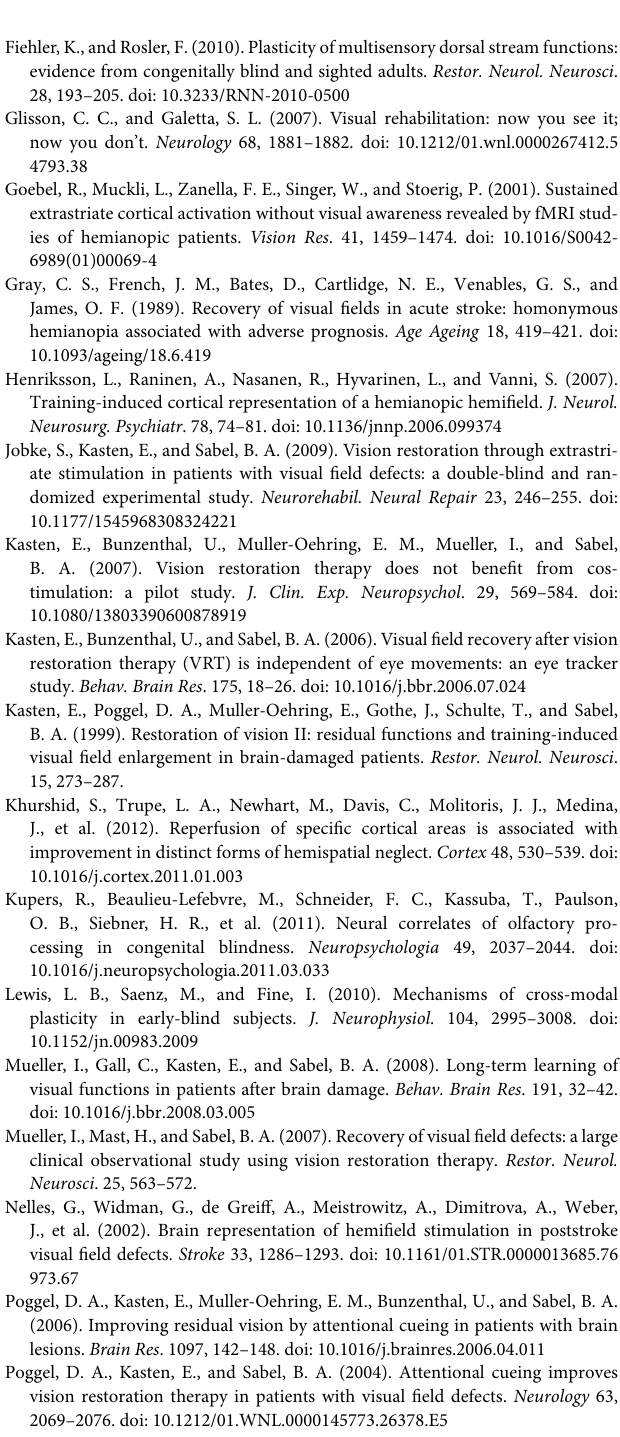
Figure S1 | Schematic of activation task. (A) Example of FACE image displaying white cross target, (B) 50% GRAY background with black central fixation cross, (C) Example of scrambled face (SCRF) image without white cross target, (D) 50% GRAY background displaying white cross target, (E) Example of FACE image without white cross target. First 100s shown but cycle continued for 240